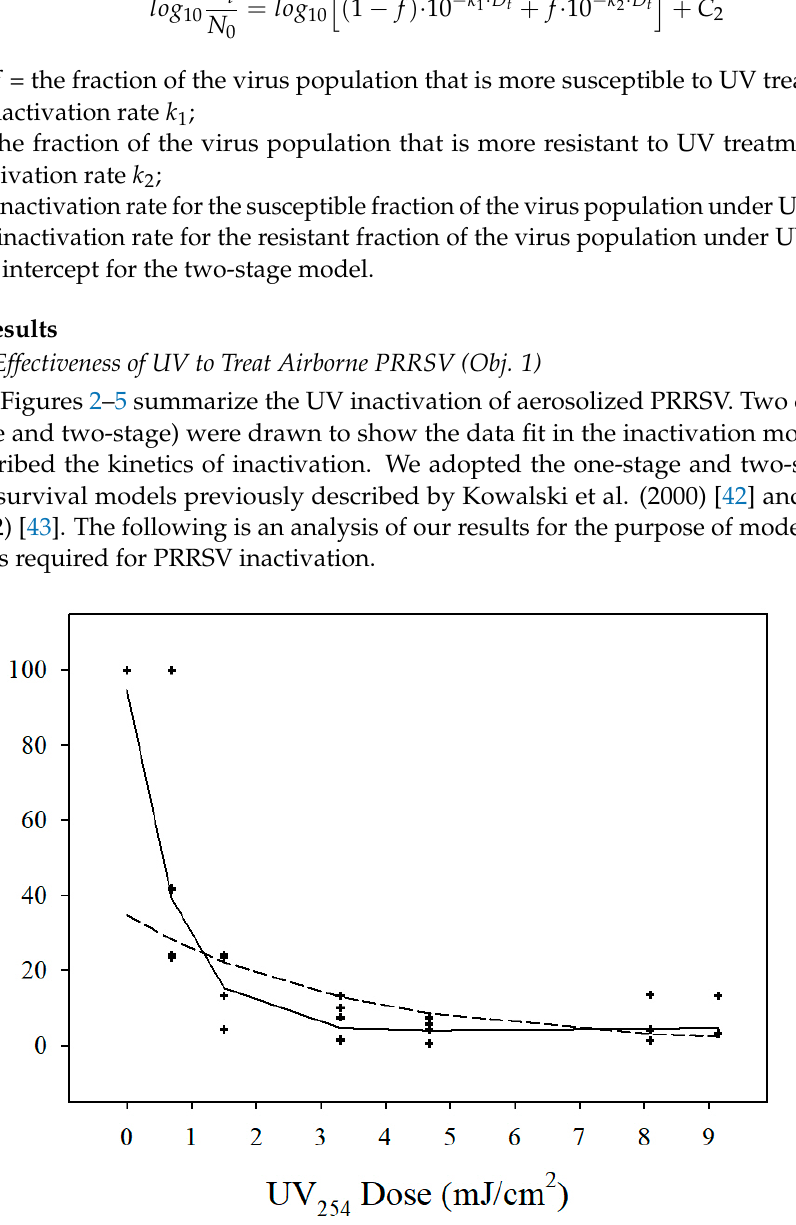
Figure 2. UV-C (254 nm) treatment inactivation of aerosolized PRRSV. PRRSV post-UV survival Figure 2. UV ‐ C (254 nm) treatment inactivation of aerosolized PRRSV. PRRSV post ‐ UV survival (%) = N t /N 0 . A log10 normalized PRRSV post-UV survival is shown in Figure A1. One-stage and (%) = N t /N 0 . A log10 normalized PRRSV post ‐ UV survival is shown in Figure A1. One ‐ stage and two-stage inactivation models are marked with dashed and solid lines, two ‐ stage inactivation models are marked with dashed and solid lines, respectively.